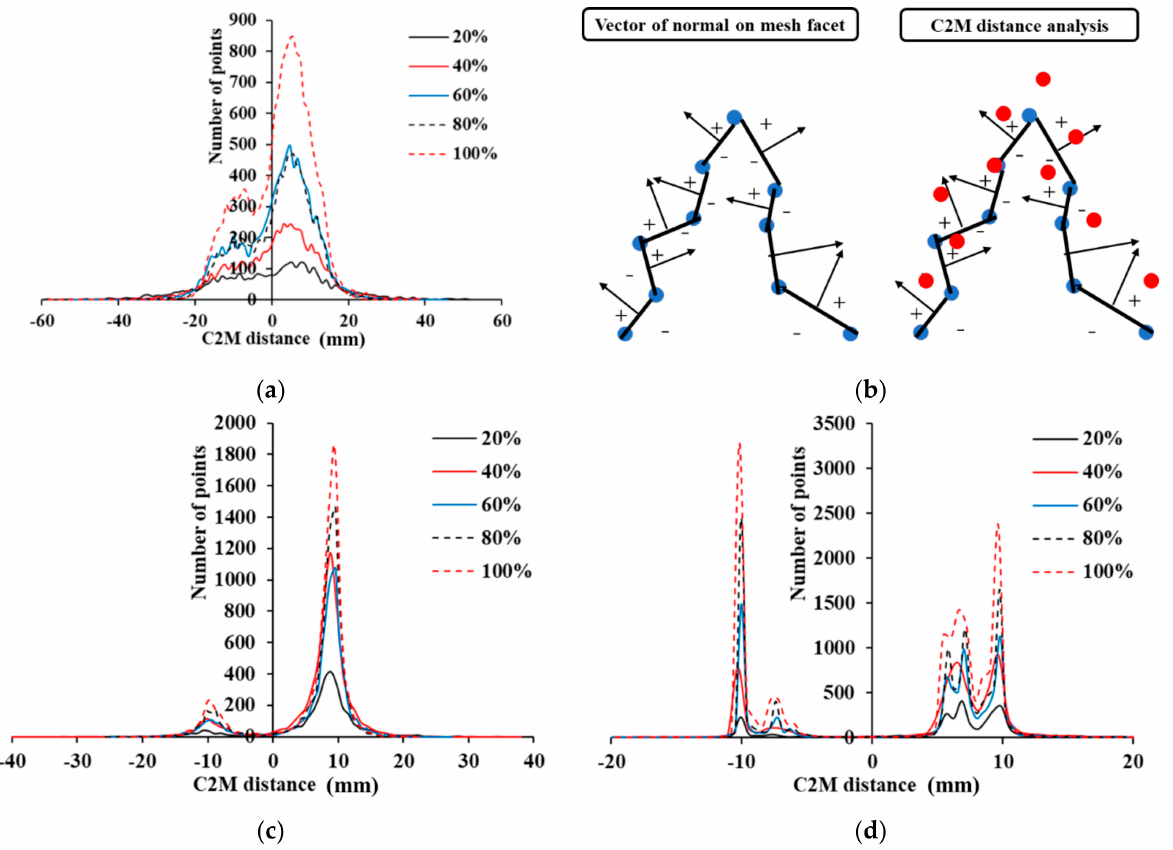
Figure 15. Causes of C2M Displacement Estimation Error, ( a ) C2M Histogram of concrete panel (10 mm shift),( b ) Schematic diagram of direction of shifted distance in C2M, ( c ) C2M Histogram of SMW (10 mm shift) ( d ) C2M Histogram of sheet pile (10 mm shift).